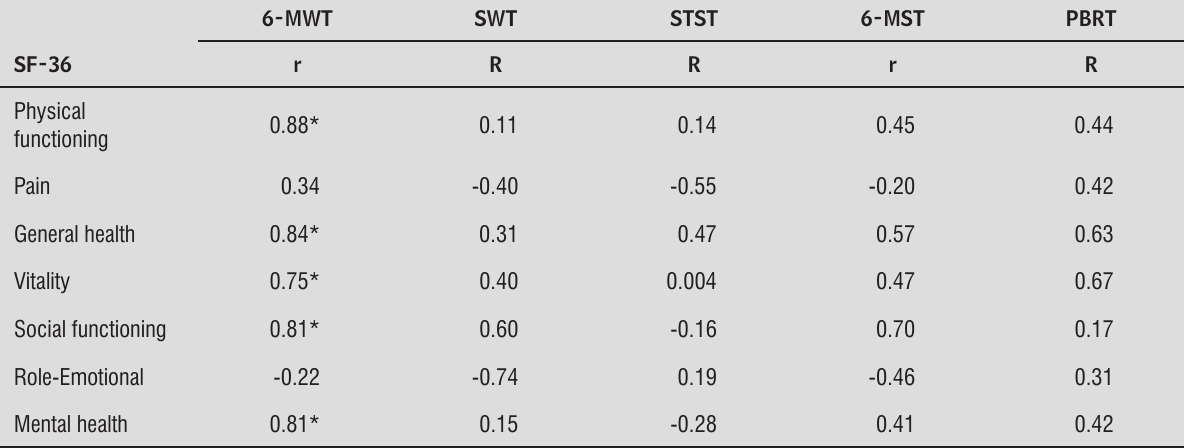
Table 4 - Correlation between functional capacity tests and the SGRQ and SF-36 questionnaires for the COPD group (n = 8)